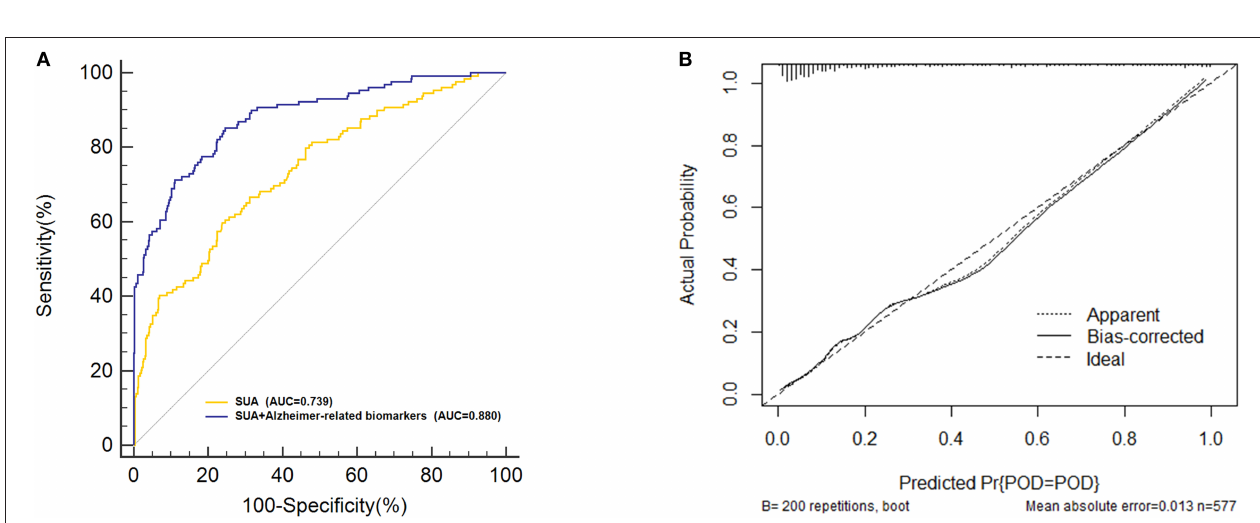
FIGURE 5 | Mediation analysis. The relationship between SUA and POD was mediated by CSF P-tau (proportion = 15.3%).